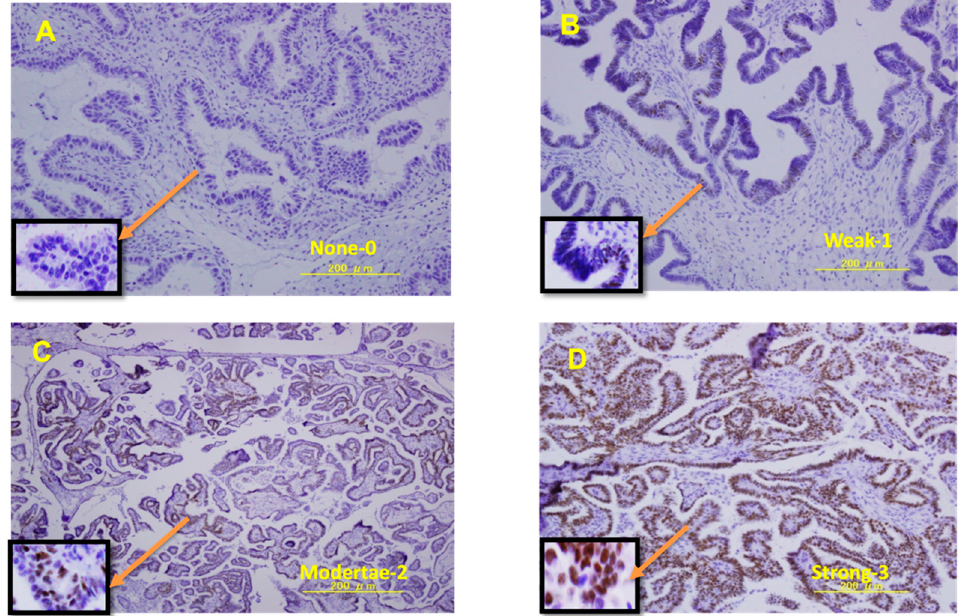
Figure 1. Representative image of ER immunostaining in LGSOCs. ( A ) Negative ER expression in LGSOCs; ( B ) weak ER expression in LGSOCs; ( C ) moderate ER expression in LGSOCs; ( D ) strong ER expression in LGSOCs. ER, estrogen receptor; LGSOCs, low-grade serous ovarian carcinomas.